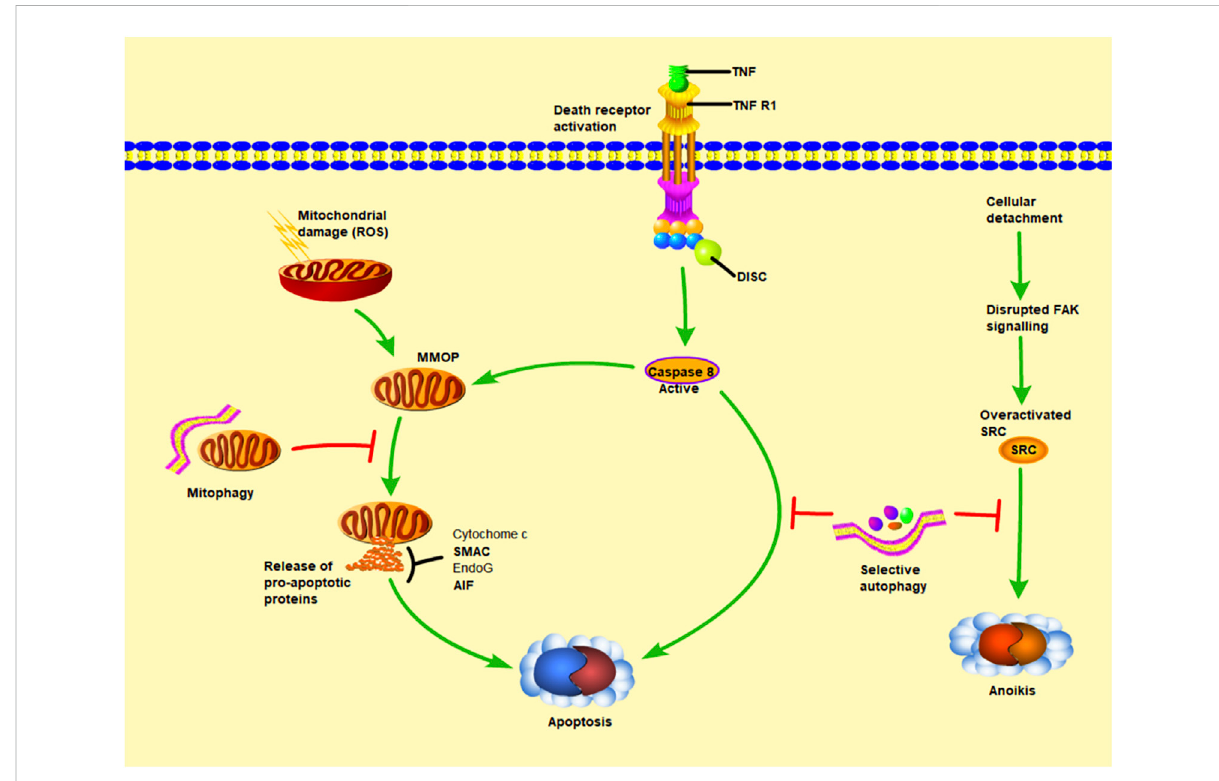
FIGURE 3 Therelationship betweenautophagyandapoptosis.MOMP(mitochondrialoutermembranepermeability)leadstothereleaseofcytochromec (cytochrome c), AIF (apoptosis inducing factor), EndoG (endonuclease G). Among them, cytochrome c can promote caspase-9 and APAF1 (apoptosis protease activating factor 1) to combine into apoptosis complex, thereby inducing downstream apoptosis. The other way that can independently promote apoptosis is LMP (lysosomal membrane permeability), which stimulates the release of cathepsin into the cytoplasm. Cathepsin can also promote MOMP and strengthen the apoptosis pathway other than its own. Under normal conditions, autophagy maintains intracellular homeostasis by removing damaged proteins and aging organelles. However, during liver ischemia-reperfusion, a large amount of autophagy will lead to the accumulation of autophages and abnormal degradation of proteins and organelles, thus accelerating this